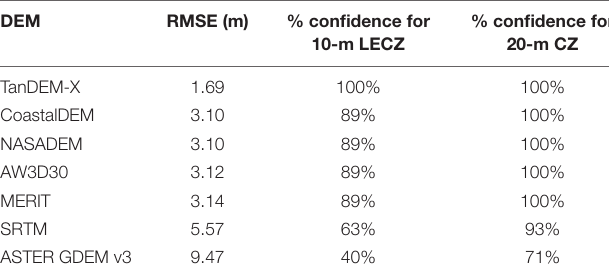
TABLE 5 | The confidence level for delineating the 10-m LECZ and the 20-m coastal zone (CZ) using each global DEM. DEM RMSE (m) % confidence for